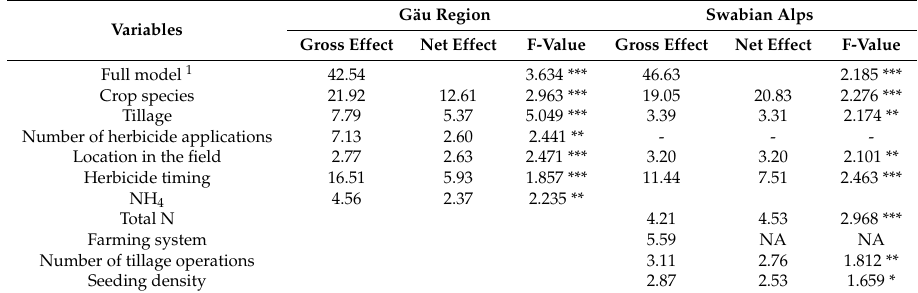
Table 2. Explained variation (%) of the full model, as well as the gross (redundancy analysis (RDA) with single explanatory variable) and net ((partial) RDA with single explanatory variable and additional variables held constant) effects of the explanatory variables on weed species composition and their F-values from the permutation test for the Gäu region and the Swabian Alps. Gäu Region